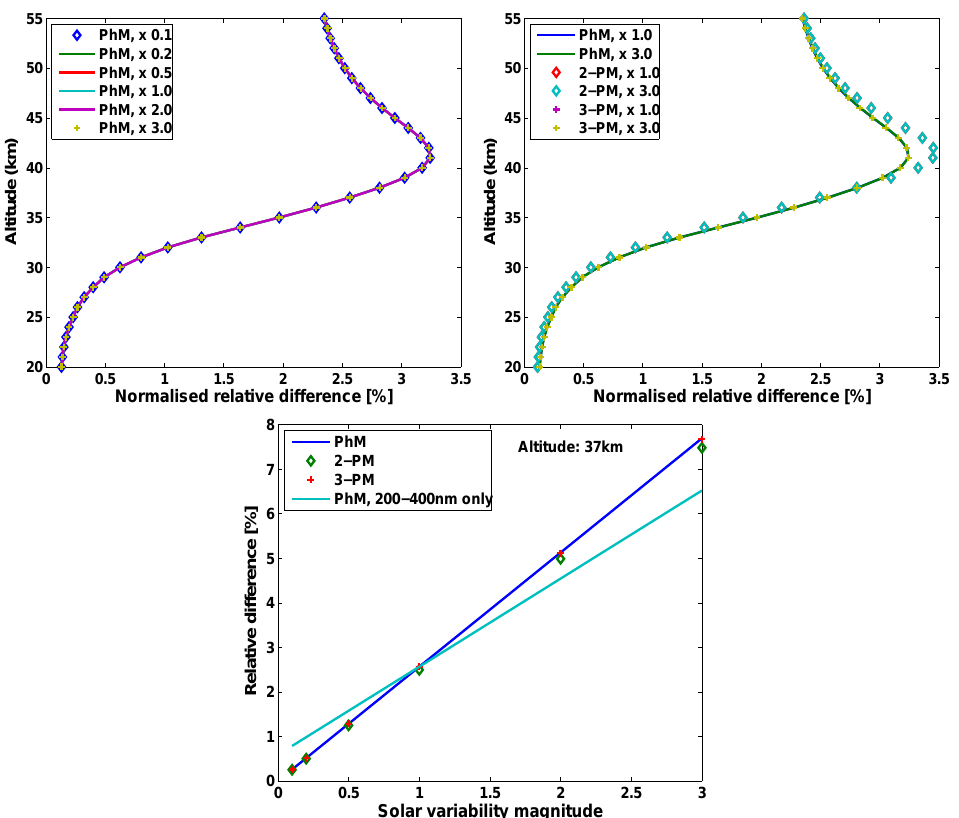
Fig. 9. Normalised relative difference in O x concentration between solar maximum and solar minimum experiments for various solar vari- ability magnitudes. The relative difference is calculated as the solar maximum–minimum difference divided by the O x concentration, and normalised by the solar variability magnitude. A solar variability magnitude of one corresponds to Lean (1997) solar maximum and minimum spectra. Top left: photochemical model (PhM) with solar variability magnitudes from 0.1 to 3.0. Top right: photochemical model, 2-predictor model (2-PM) and 3-predictor model (3-PM) with solar variability magnitudes 1.0 and 3.0. Bottom: normalised relative difference at 37km altitude as a function of the solar variability magnitude for the photochemical model and the 2- and 3-predictor models. In addition, the light blue line shows the response of the photochemical model with the solar variability magnified with respect to Lean (1997) only in the range